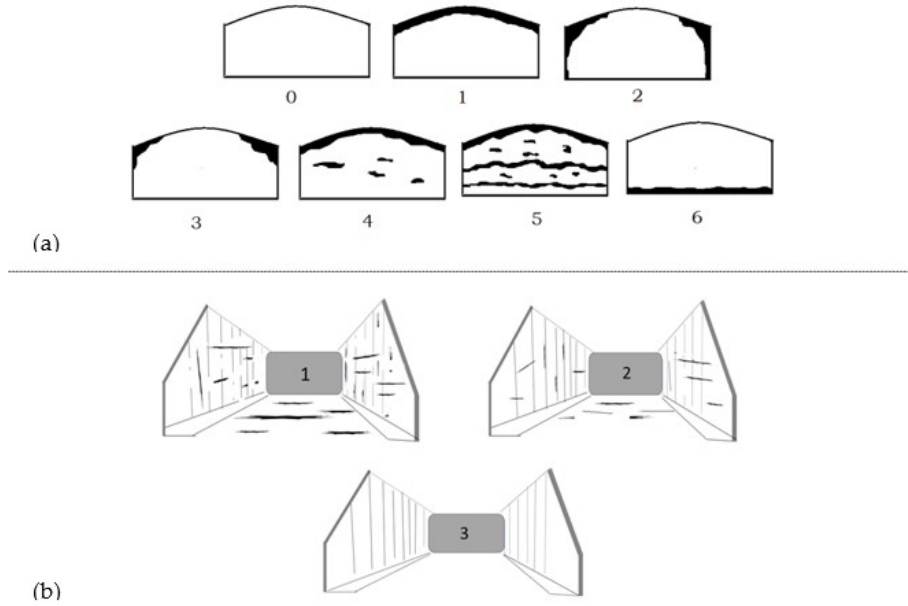
Figure 1. ( a ) Silage visual spoilage code used to identify the distribution of the spoiling point on the silo face (adapted from Mickan et al. [21]); ( b ) visual code to identify the bunker maintenance